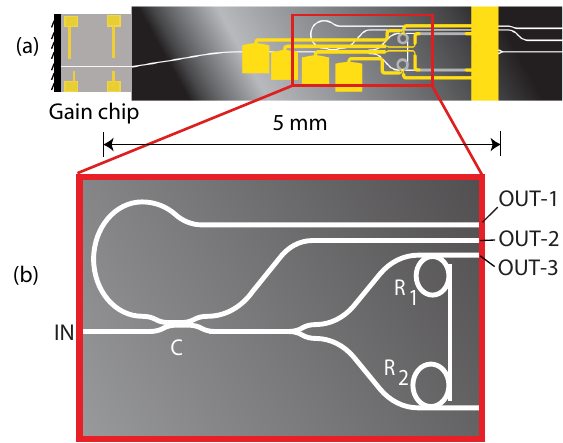
Figure 2. Schematic of the tunable reflector waveguide chip. ( a ) Complete chip of the waveguide The waveguides are depicted in white, electrical contacts are yellow, and the heaters are grey. ( b ) Dual micro-ring resonators, R 1 and R 2 , where “C” is marked as coupler, “IN” is marked as the input port of the waveguide chip, “ OUT − 1” and “ OUT − 2” are marked as output ports of the computation channel, and “ OUT − 3” marks the output port of the WECSL. (Reproduced with modification by permission from Laser Physics Letters